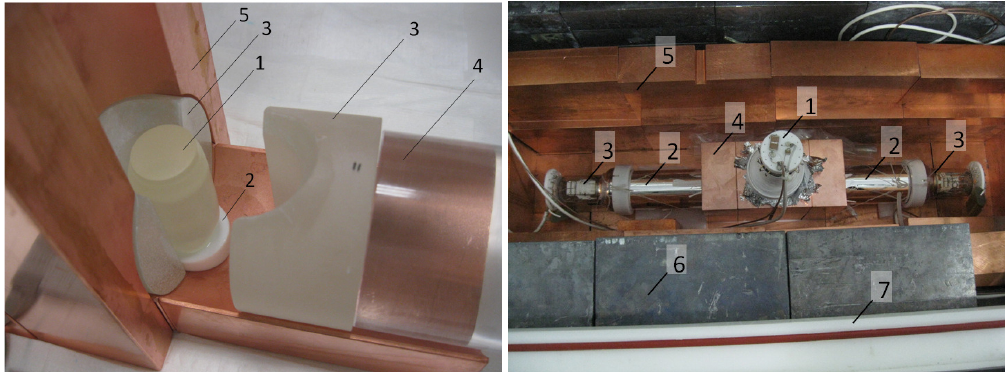
Figure 3. Left photograph: the 106 CdWO 4 crystal scintillator (1), Teflon support of the 106 CdWO 4 crystal (2), CdWO 4 crystal scintillators (3), quartz light-guide (4), “internal copper” brick (5). Right photograph: the detector system installed in the passive shield: PMT of the 106 CdWO 4 detector (1), light-guides of the CdWO 4 counters wrapped by reflecting foil (2), PMT of the CdWO 4 counters (3), “internal copper” bricks (4), “external copper” bricks (5), lead bricks (6), and polyethylene shield (7). The copper, lead and polyethylene shields are not